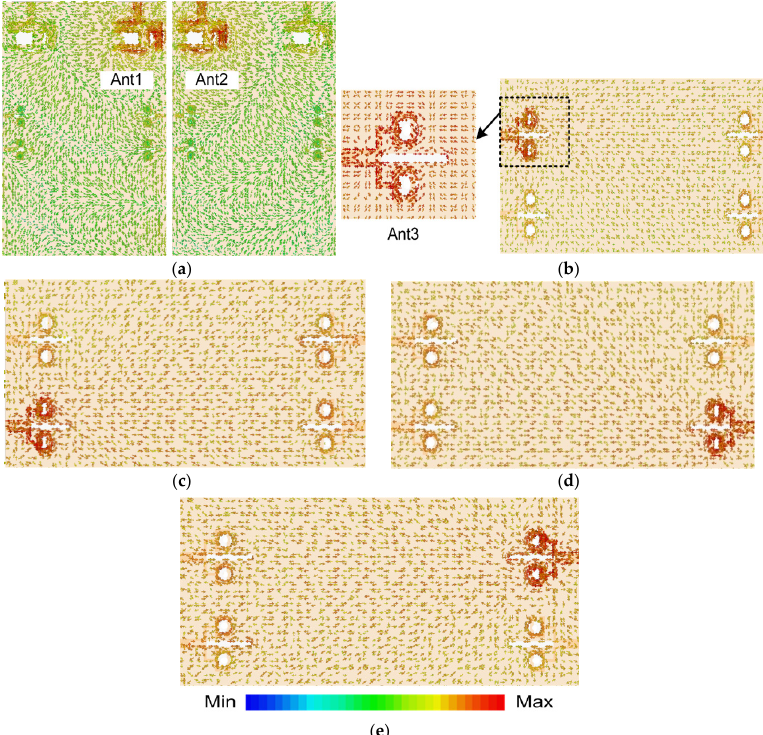
Figure 7. Surface Current Distribution for: ( a ) LTE MIMO Antennas at 5.9 GHz; ( b ) 5G Ant3; ( c ) 5G Ant4; ( d ) 5G Ant5; ( e ) 5G Ant6 (For all 5G Antennas current distribution is investigated at 28 GHz).